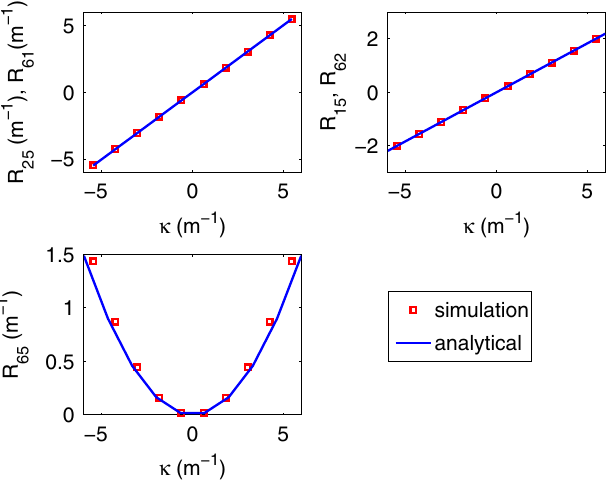
FIG. 17. Comparison of the analytical (solid lines) and nu- merical (squares) calculations of the (cid:6) -dependent elements of transfer matrix associated to the deflecting cavity considered in this paper. The analytical results are computed using Eq. (A2) while the numerical results are derived from tracking simulations with IMPACT-T